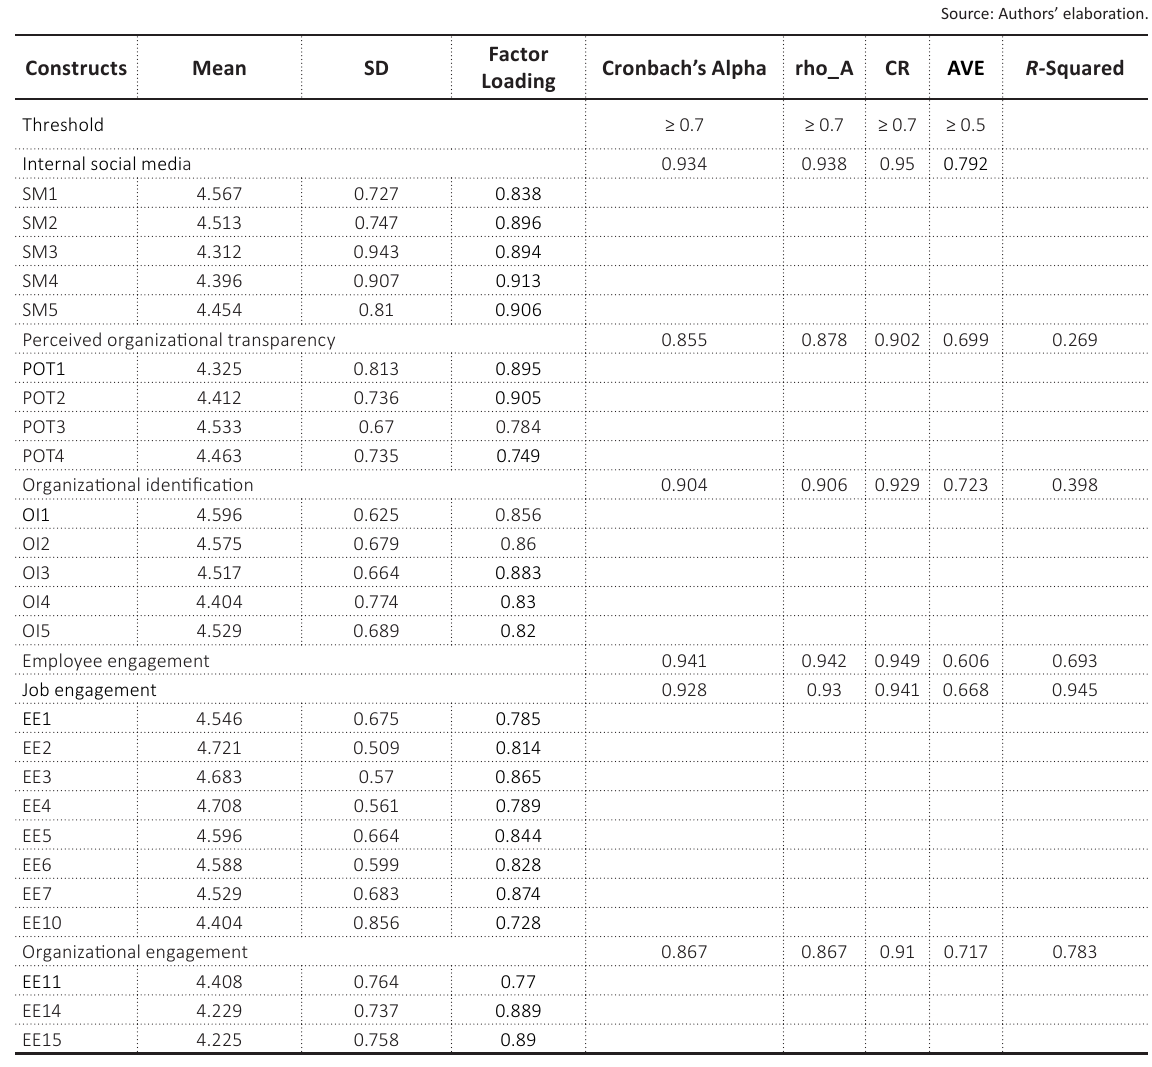
Table A1. Reliability and convergent validity of the latent constructs